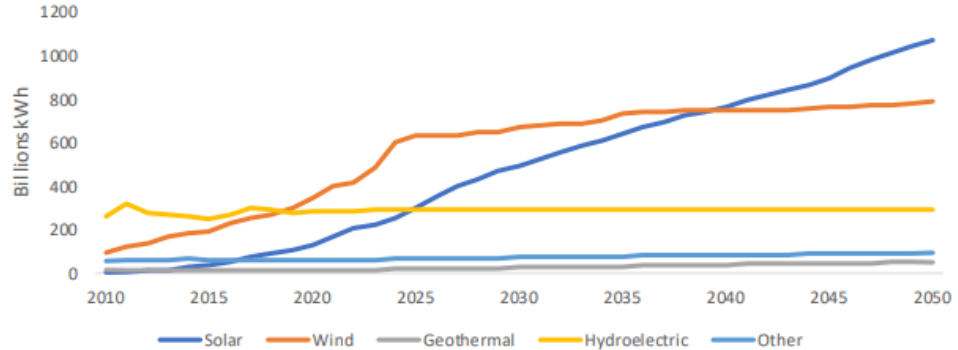
Figure 1. Renewable energy outlook in the USA until the end of 2050 [4]. Accessed online with permission (open access) from United States Energy Information Administration (2021).